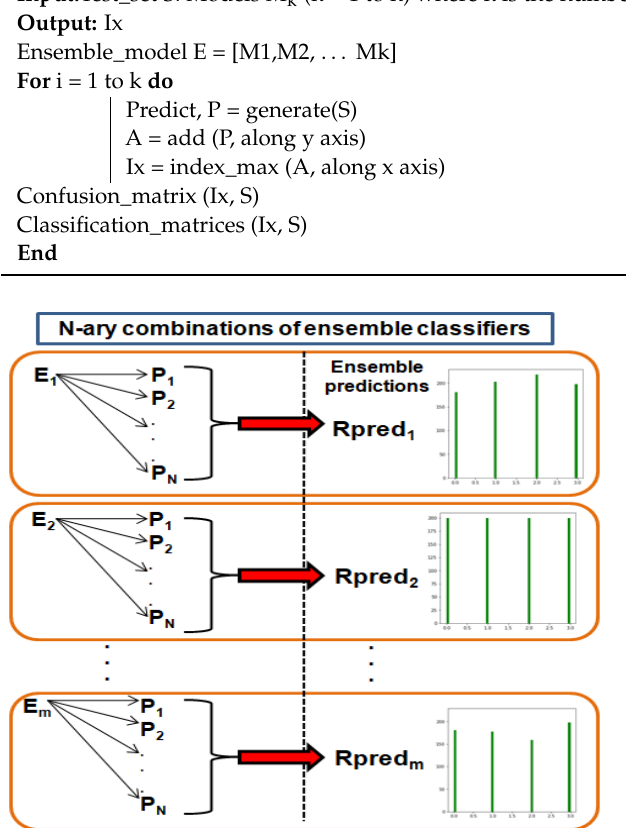
Figure 6. Ensemble averaging technique used in this study.